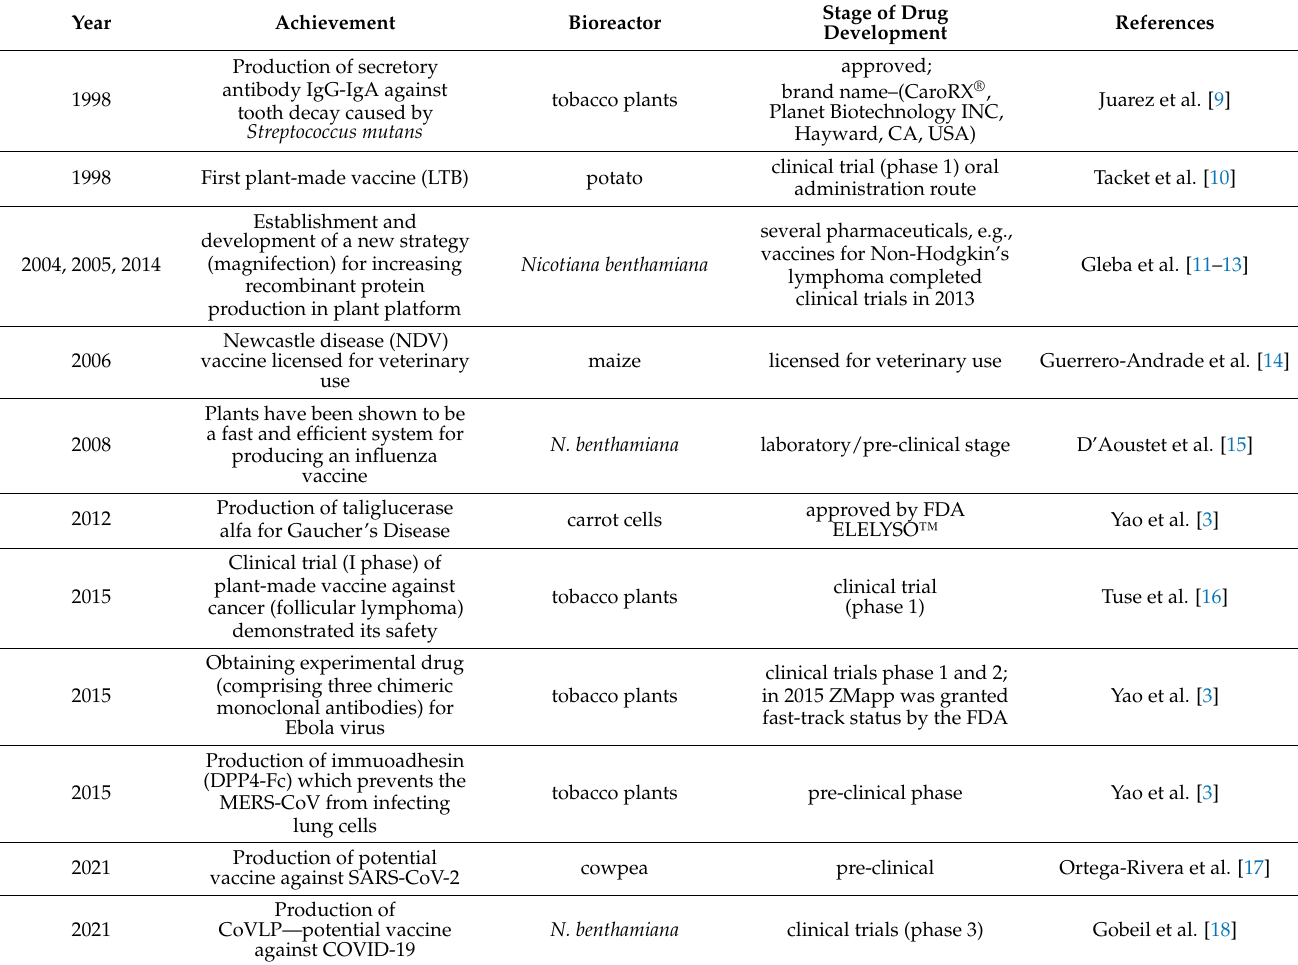
Table 1. Crucial facts in the development of plant-made